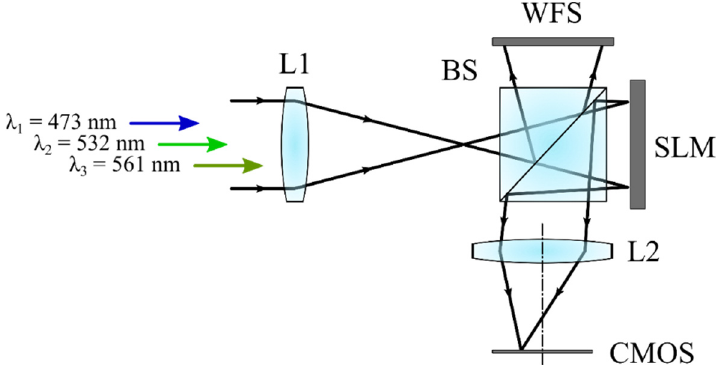
Figure 3. Simplified experimental scheme.